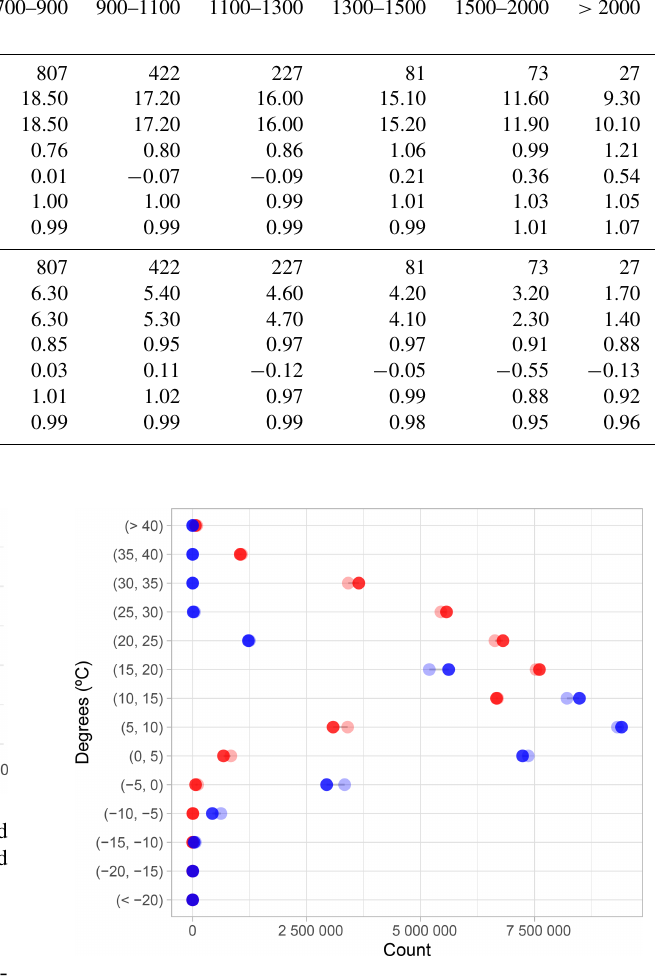
Figure 9. Comparison of frequencies by categories between ob- served (solid) and predicted (transparent) maximum (red) and min- imum (blue)